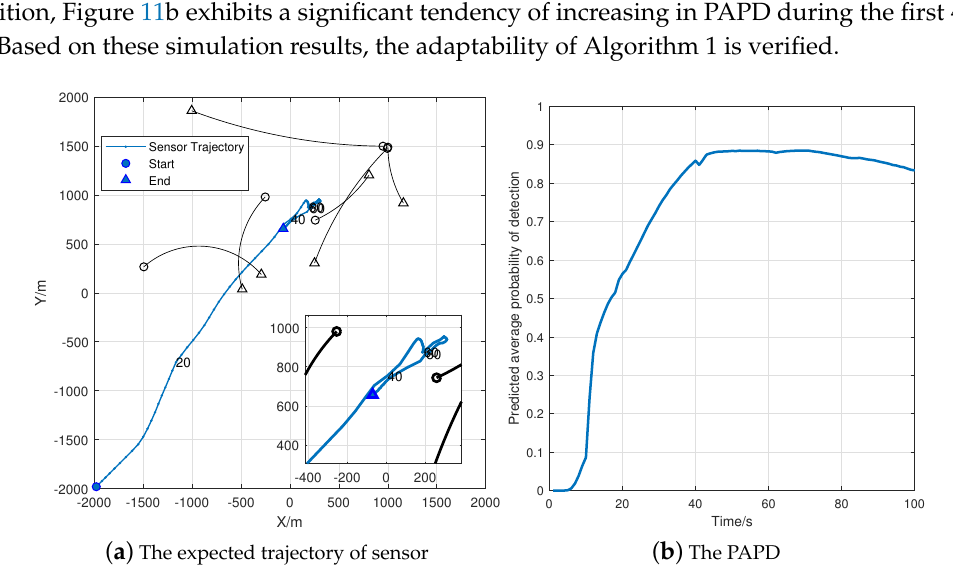
Figure 11. Simulation results using the alternative p D function (100 Monte Carlo